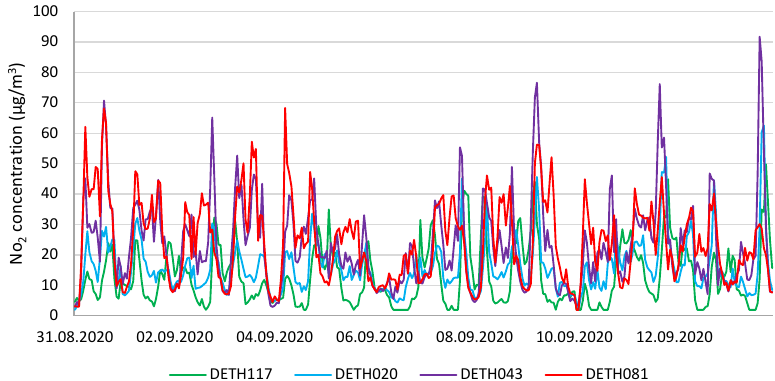
Figure 4. NO 2 concentration for the four sensors, first two weeks of September 2020.